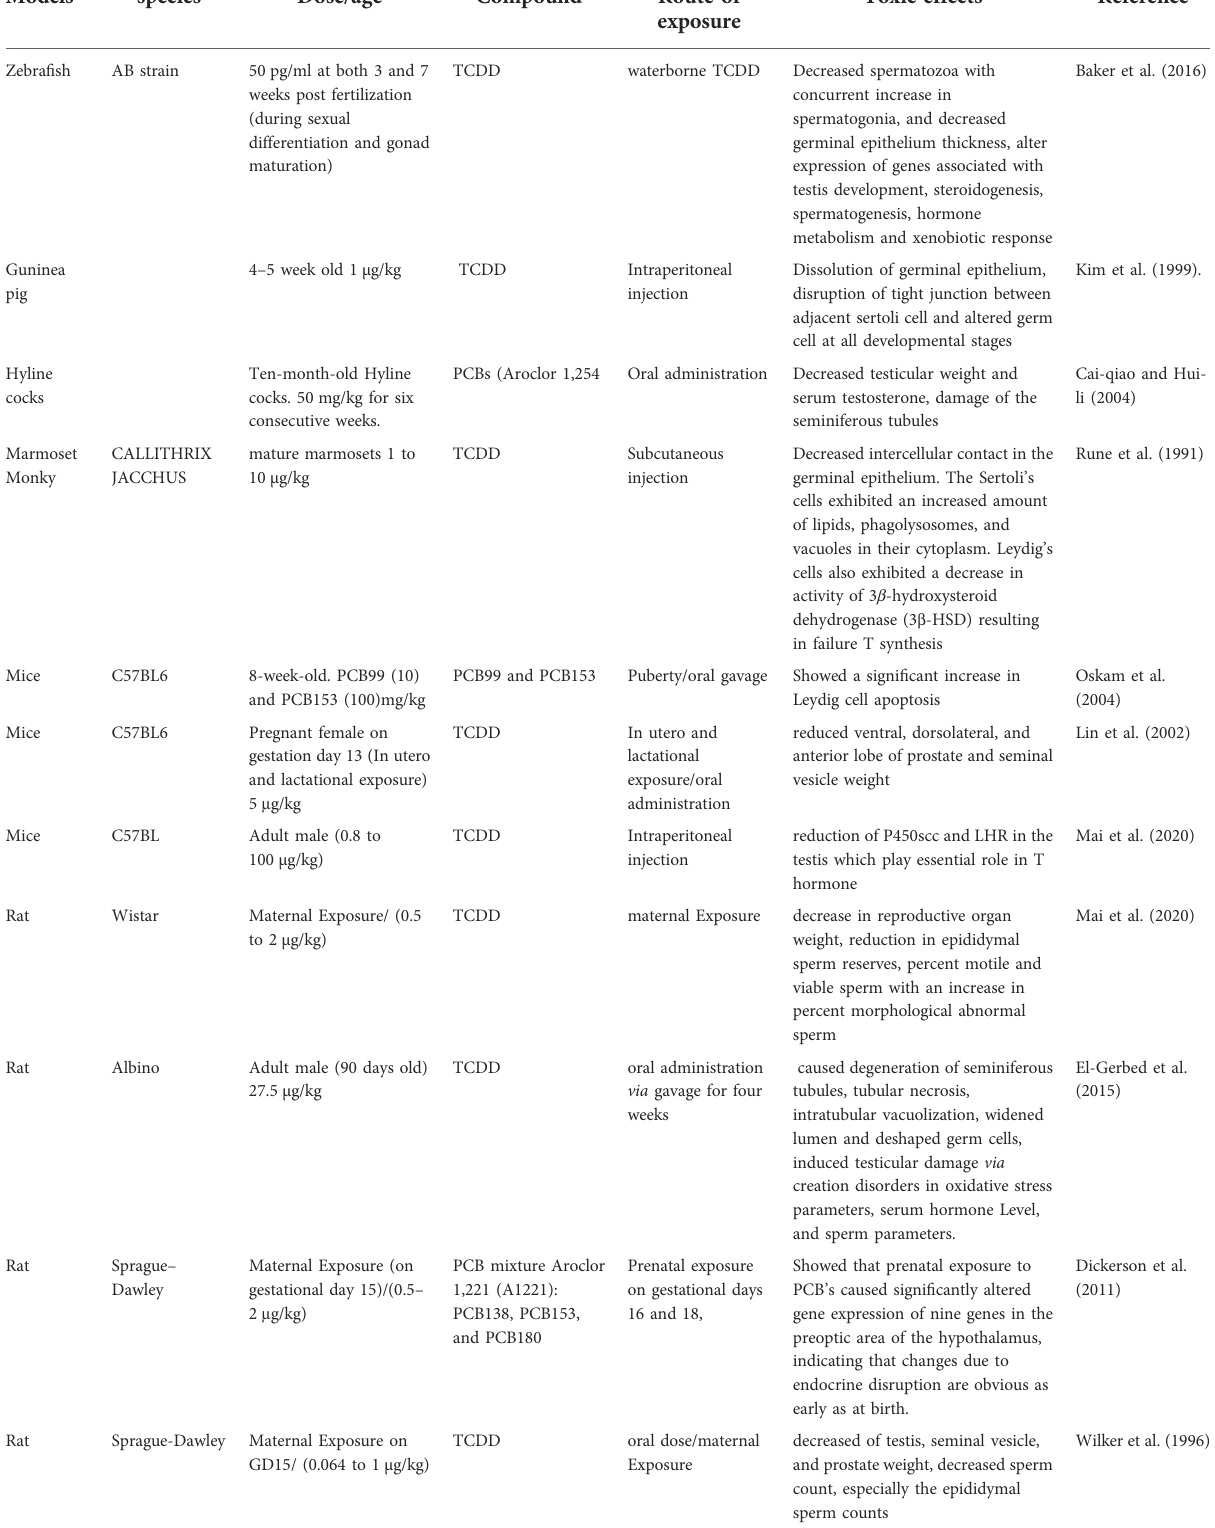
TABLE 2 Summarizes the information on the models, species, molecules used and effects of dioxins on